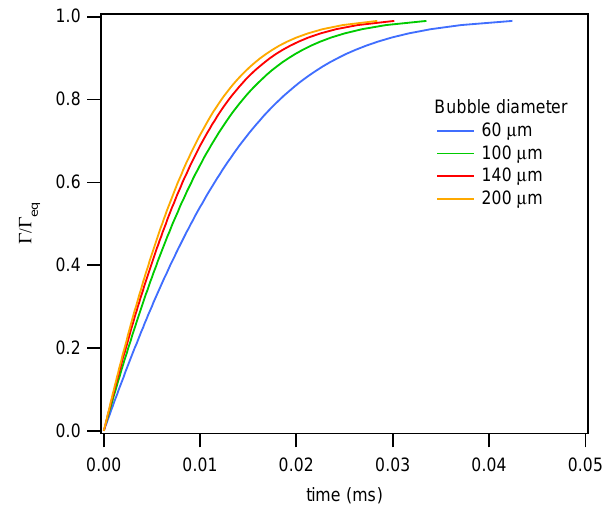
Fig. 12. Prediction of 0 / 0 eq ratio as a function of time for bub- bles generated by a small-scale plunging water jet in a solution with 5.77µM T. rotula exudate concentration. The exudate concentration corresponds to 512µM DOC organic content (biogenic molecule to C mass ratio= 1.87 (Fraga,